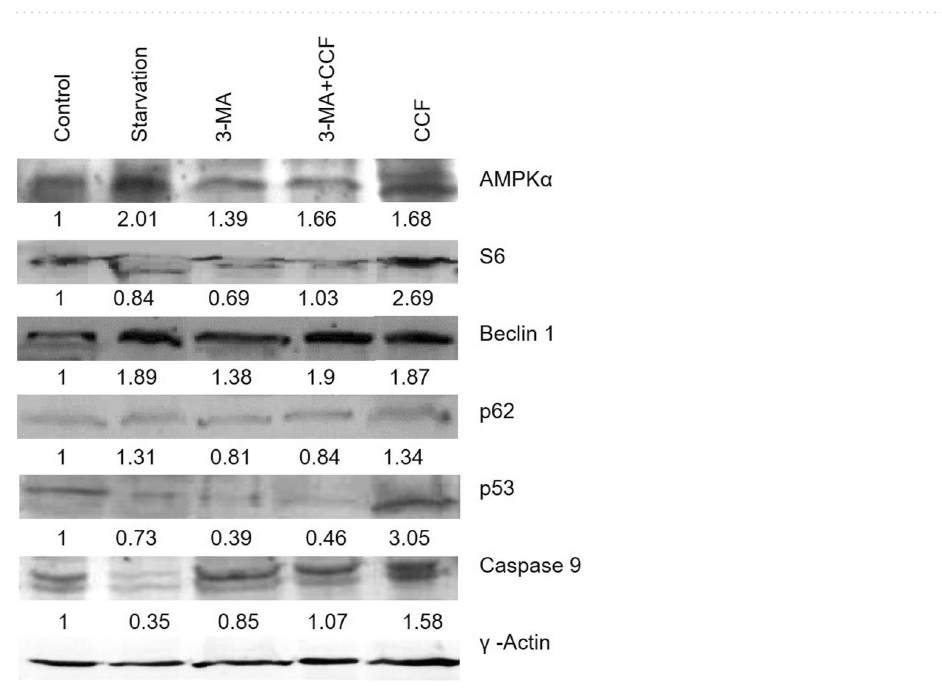
Figure 4. Autophagosome formation in CCF treated cells, ( a ) acridine orange stained cells under fluorescence microscope showing acidic compartments as bright red specs, scale represents 50 µm, inset showing magnified view; ( b ) Scatter plots showing flow cytometric quantification of acidic compartments, bar graph showing percentage of population with acidic vacuoles, values were expressed as mean ± SD of three independent experiments (n = 3); *denotes significant difference between control and treated sets ( P < 0.05). ( c ) Expressions for autophagic marker protein LC3B, γ-actin served as loading control, densitometric analysis (ImageJ 1.52A ) of LC3B-II/LC3B-I expressions ratios were presented below the respective blot pictures. [Blot figures for different sets in ( c ) were cropped from same gel. Detailed information was given as Supplementary Information].